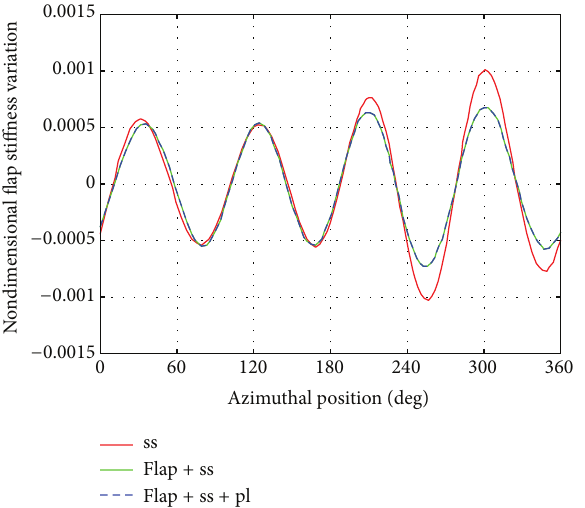
Figure 7: Pitch link stiffness time history.